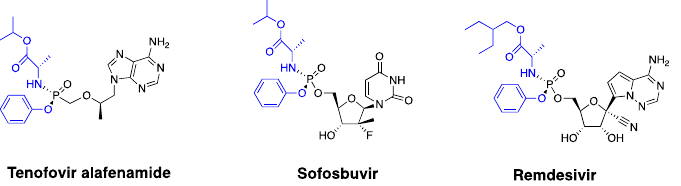
Figure 1. Chemical structures of the three FDA-approved antiviral ProTides, tenofovir alafenamide (TAF), sofosbuvir (SBV), and remdesivir (RDV). Two oxygens of monophosphate/monophosphonate are masked by an aryloxy group and an amino acid ester group (highlighted in blue).